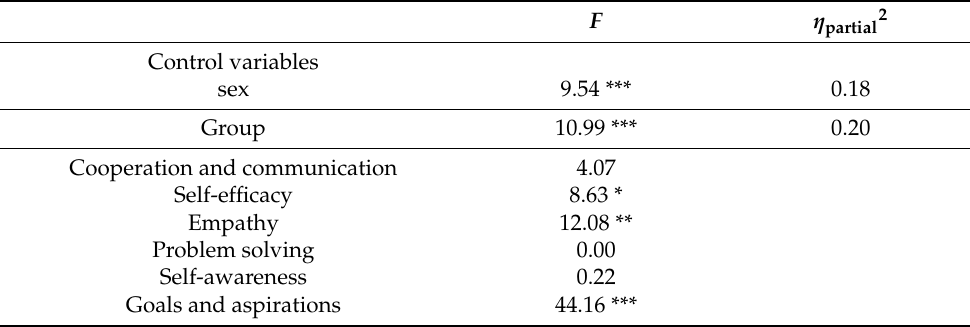
Table 3. Differences on HKRAM between groups ( N com = 140, N inst =